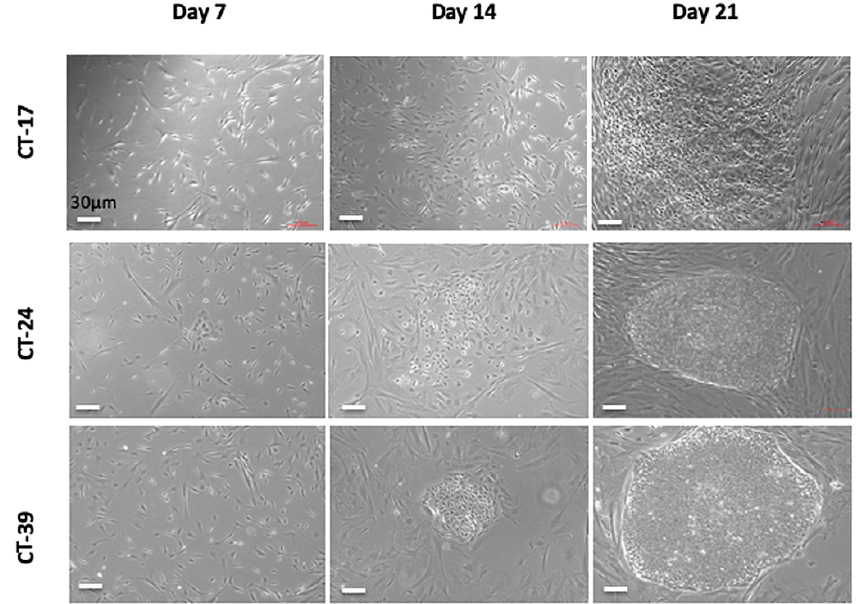
Figure 2. Observed changes to the CT-MSC during reprogramming. The CT-MSCs’ transition throughout the 21 days of reprogramming. Colonies present with a human embryonic stem cell-like morphology with defined boarders and a high ratio of nucleus to cytoplasm. The colonies were then picked and expanded for further characterization. Scale bar = 30 µM for all panels.